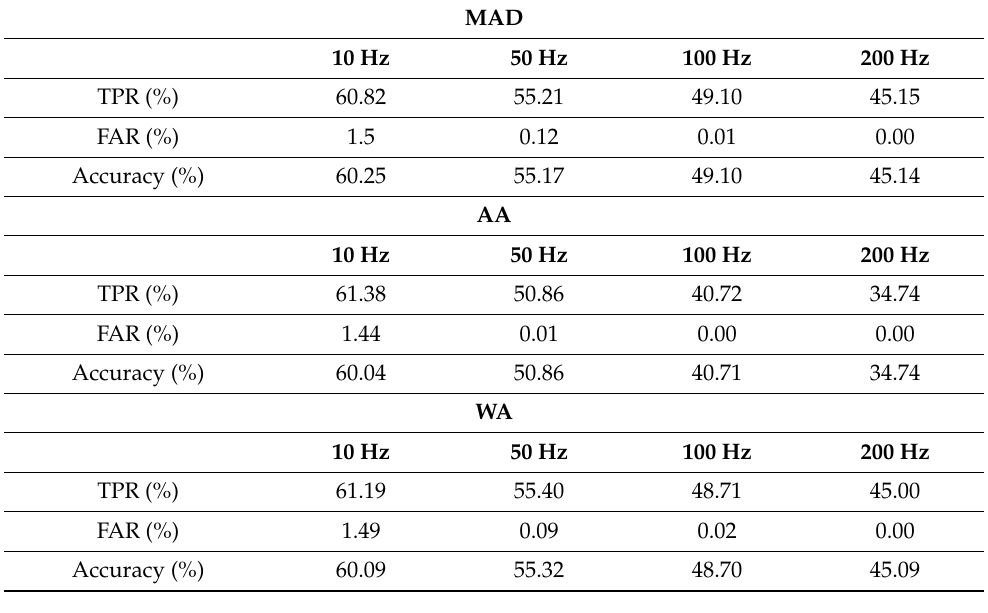
Table 3. Detection performances of post-norm algorithm at different firing rates at SNR = 0 dB (C = 50).